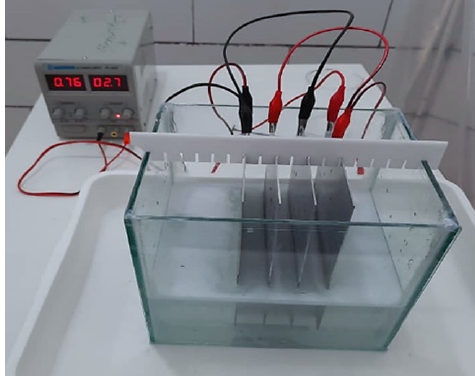
Figure 1. Experimental set-up of the used electrocoagulation system.